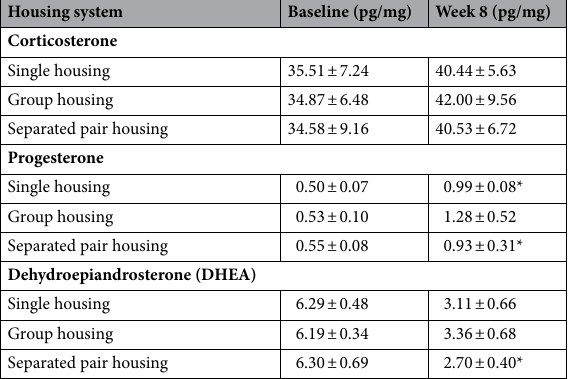
Table 3. Hair hormones. Data are given as mean ± standard deviation. Hair samples were analyzed from 16 single-housed, 16 group-housed, and 14 separated pair-housed mice. Two pair-housed mice were excluded from statistics because they there was not enough sample material for analysis. * p < 0.05 versus